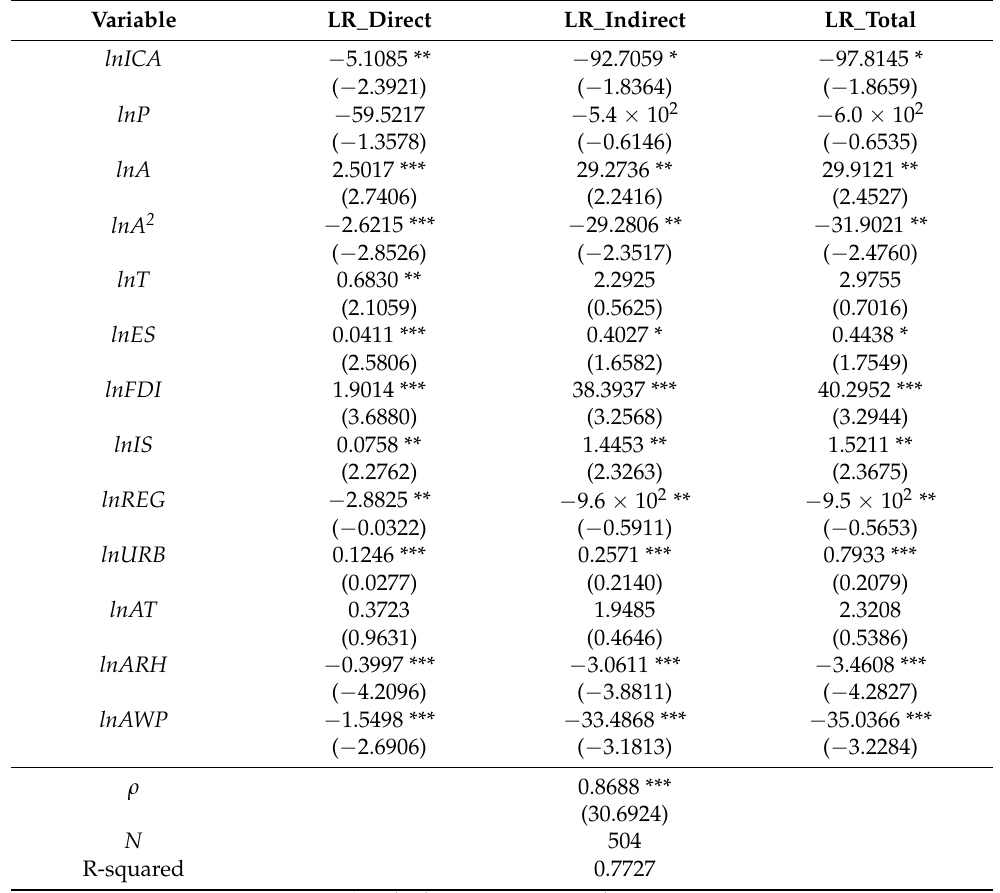
Table 7. Spatial effect decomposition results for the robustness